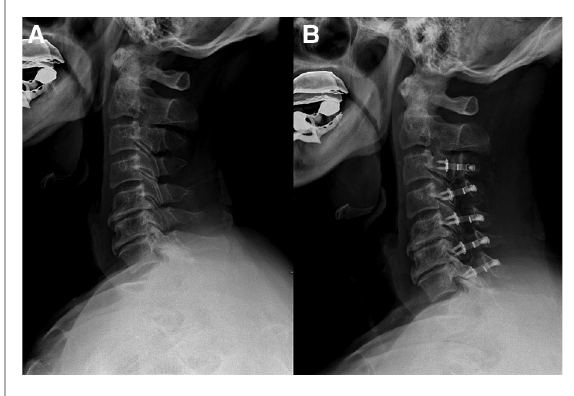
FIGURE 2 A 65-year-old male patient treated with C3 – C7 laminoplasty. ( A ) Preoperative lateral cervical radiograph (CSVA=15.4 mm, T1S= 23.4°). ( B ) Lateral cervical radiograph at fi nal follow-up (17 months after surgery, CSVA=17.5 mm).